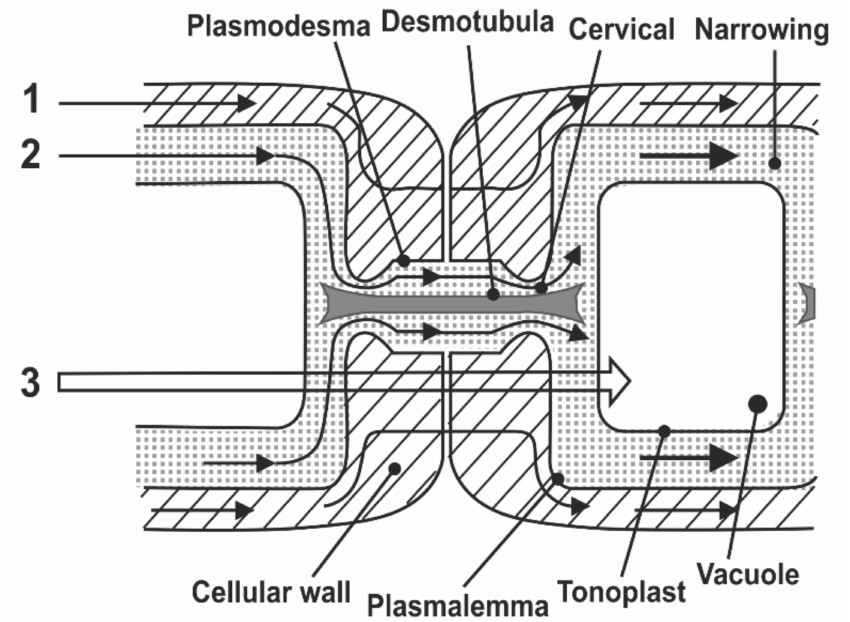
Figure 1. Scheme of water movement between root cells in the radial direction: (1) Apoplasmic way through the cell walls; (2) symplasmic way on plasmodesmata, cytoplasm; (3) cell-to-cell way through tonoplast, cytoplasm, plasmalemma, cell